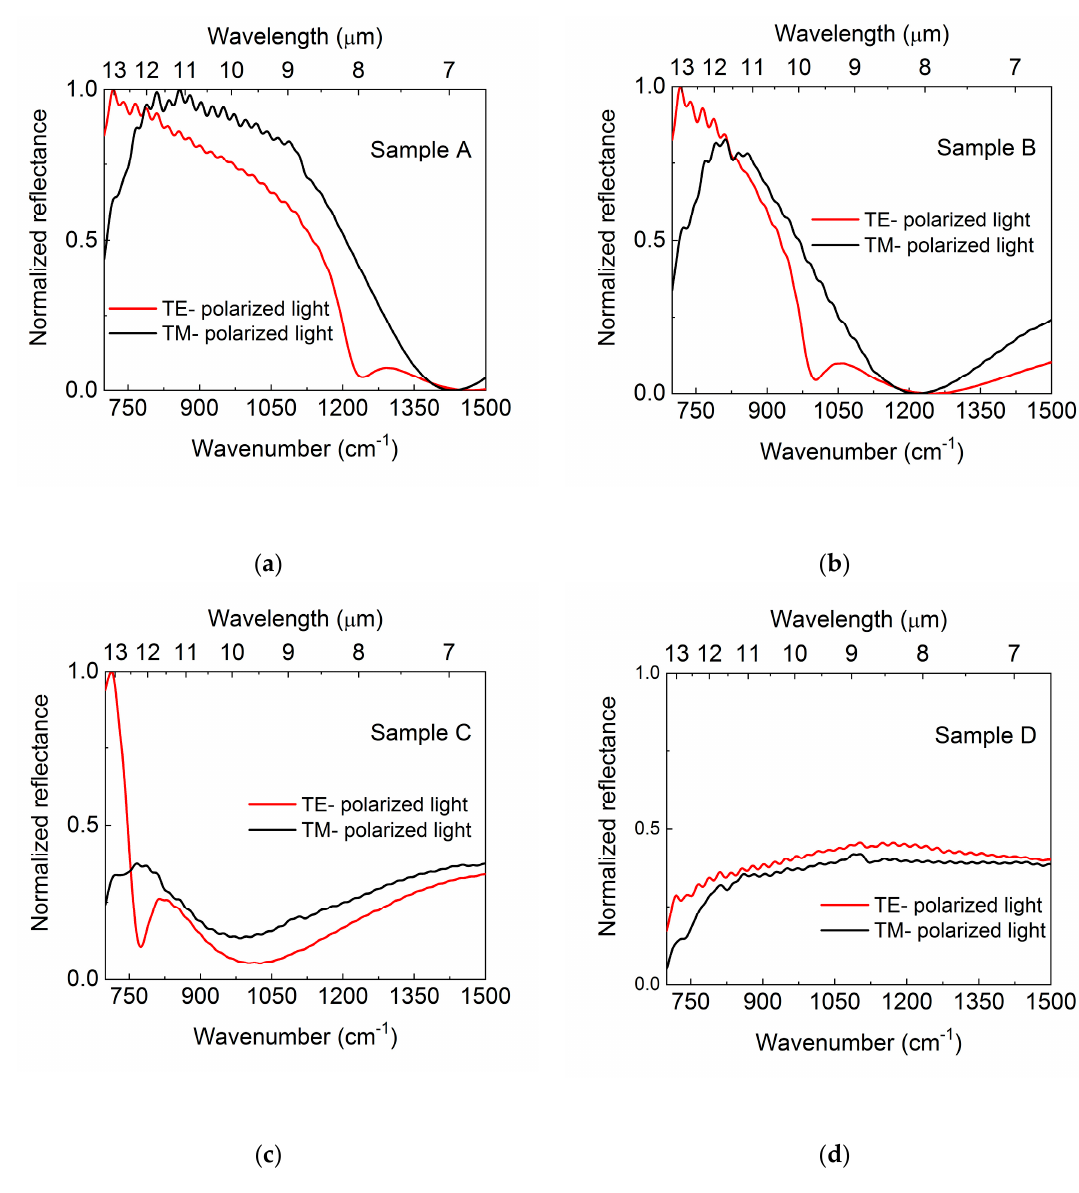
Figure 1. The reflectance spectra for two orthogonal polarizations of the probing light denoted TE (red curves) and TM (black curves): ( a ) 1.9 × 10 19 cm − 3 ; ( b ) 9.9 × 10 18 cm − 3 ; ( c ) 5.2 × 10 18 cm − 3 ; ( d ) 1.1 × 10 18 cm − 3 .